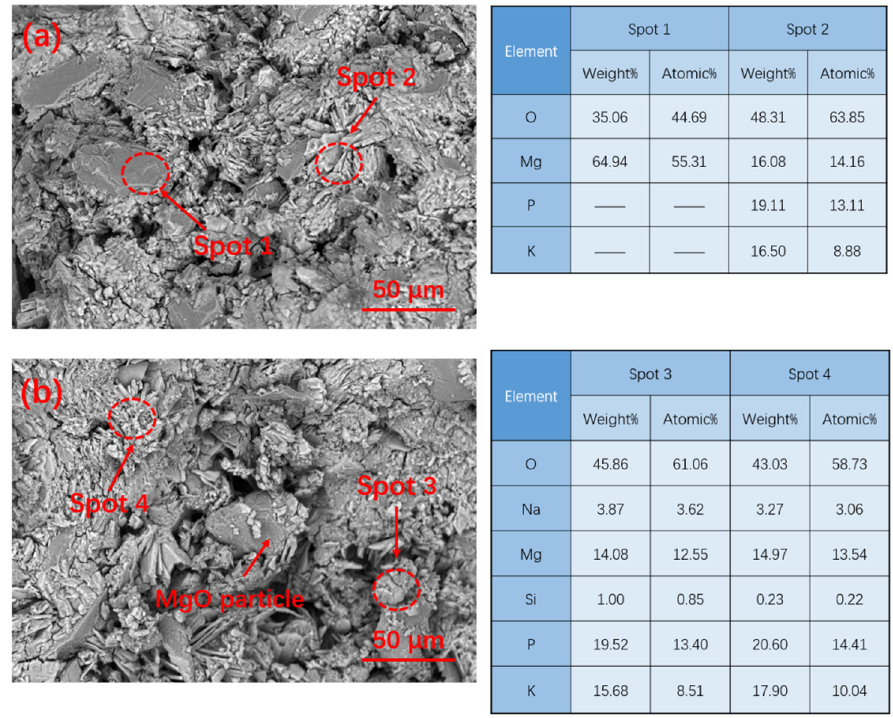
Figure 12. EDS pattern of MPC with various modified MgO curing at − 5 °C for 28 d: ( a ) G0; ( b ) G10.